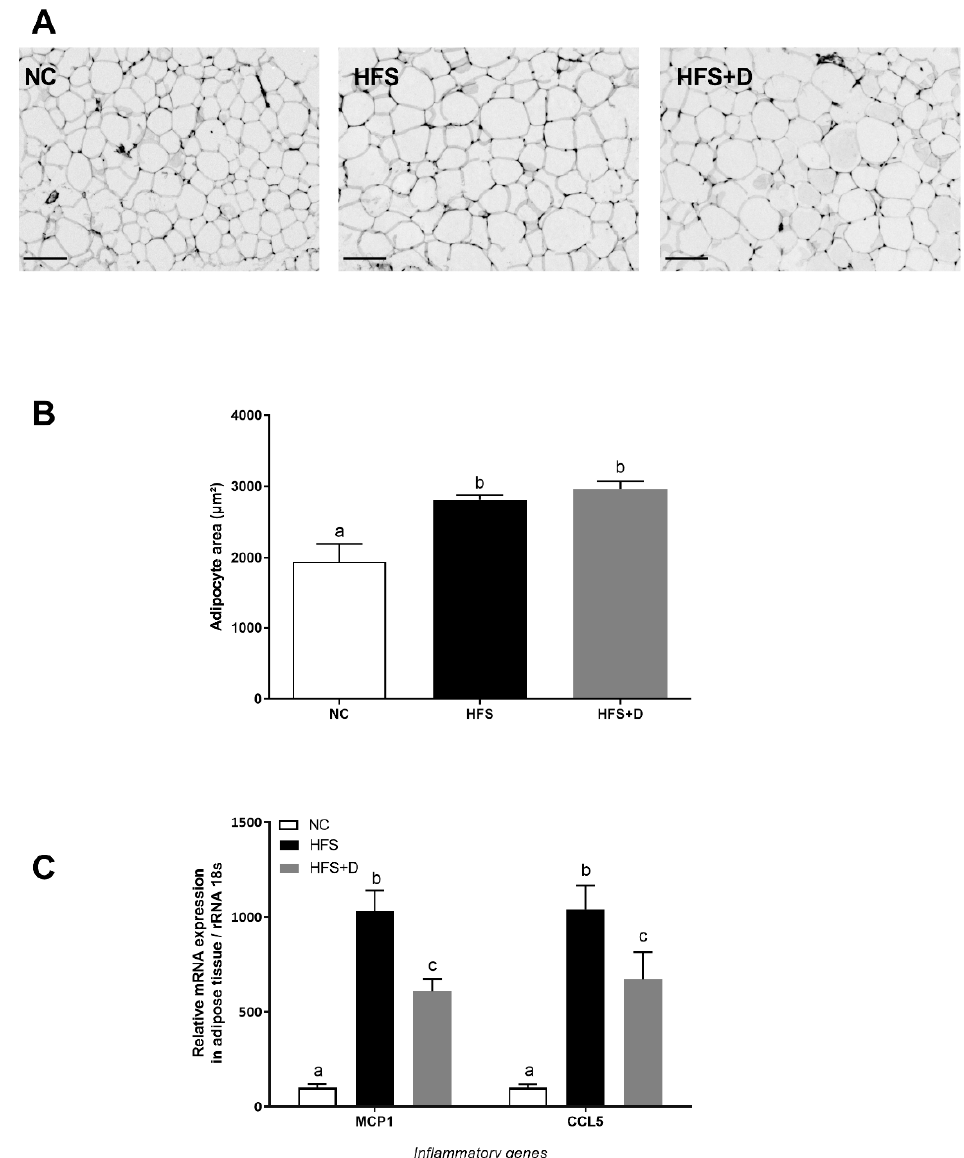
Figure 3. Effects of high-fat/high-sucrose diet and vitamin D supplementation on different parameters of inguinal adipose tissue. ( A ) Representative histological images of inguinal fat pads after H&E staining, taken at 40× magnification (scale bar represents 100 µm). NC: normal chow, HFS: high-fat/high-sucrose diet, HFS + D: high-fat/high-sucrose diet supplemented with vitamin D. ( B ) Adipocyte area, determined using Image J software. ( C ) Relative expression of mRNA inflammatory genes measured through qPCR and expressed relative to 18S ribosomal RNA. Values are presented as mean ± SEM. Values not sharing the same letter were significantly different, p < 0.05.